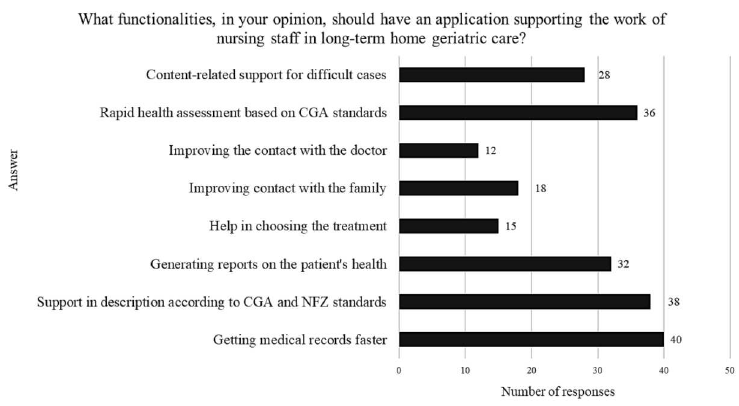
Figure 2. Desired application